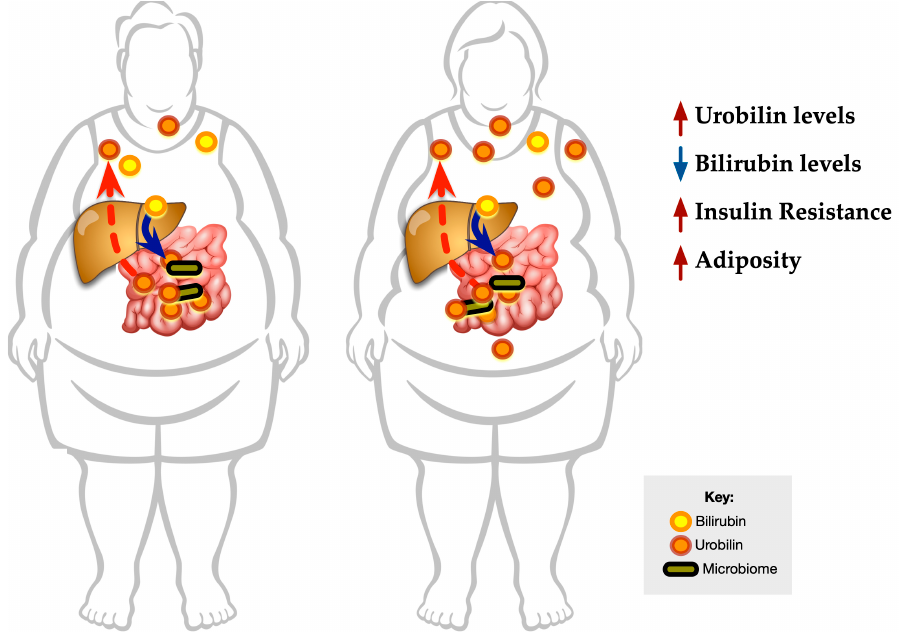
Figure 8. Urobilin and bilirubin levels in obesity . Bilirubin is conjugated in the liver and then catabolized in the intestine to form urobilin by the gut microbiome, which can be absorbed via the hepatic portal vein. The plasma levels of urobilin are positively associated with adiposity and BMI and might be a regulator of insulin resistance. Bilirubin is negatively associated with adiposity and BMI.